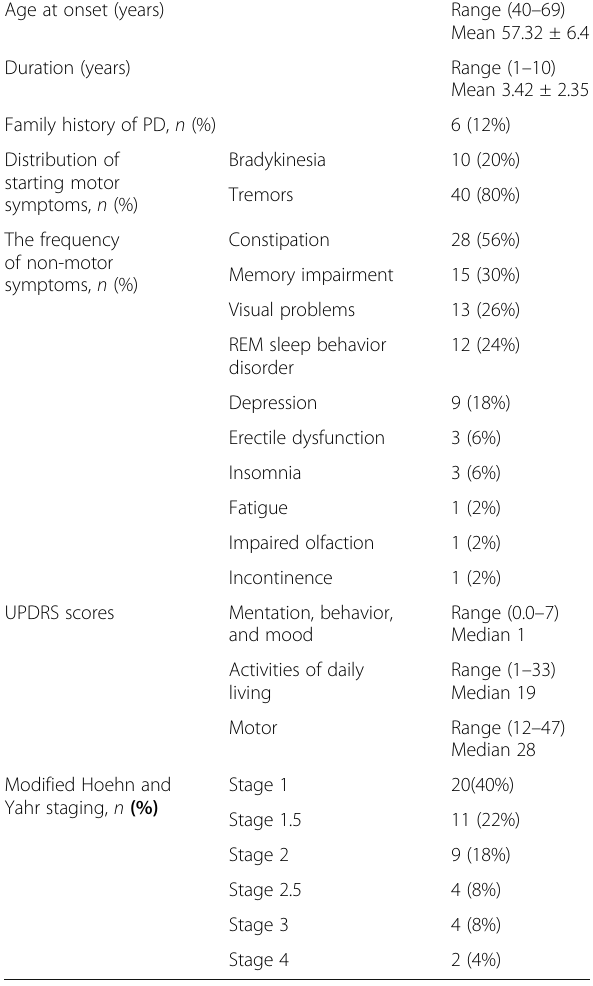
Table 1 Characteristics of PD patients